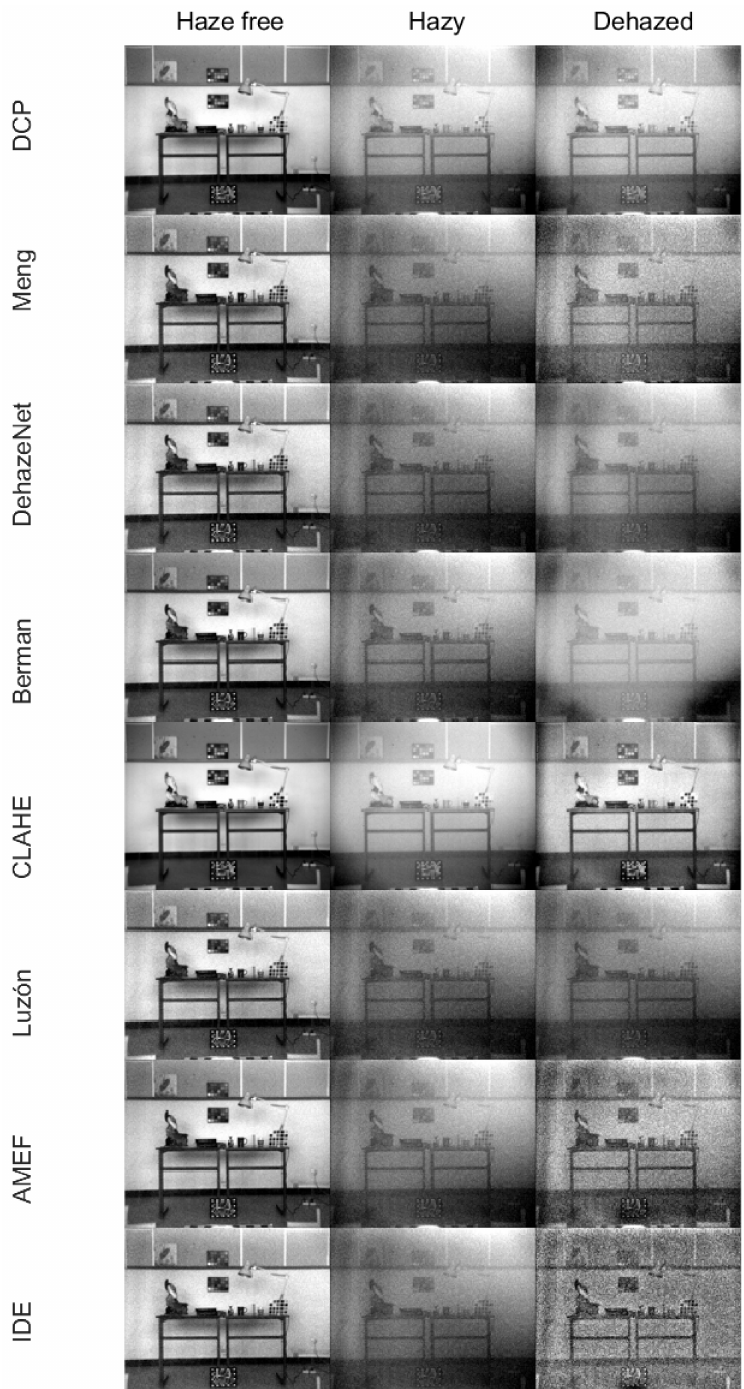
Figure 3. Original haze-free images ( left ), hazy images (next) and dehazed images ( right ). The images correspond to grayscale images generated from the average intensity of the three channels of the optimum triplets for each selected dehazing method, including a contrast stretch step only for visualization